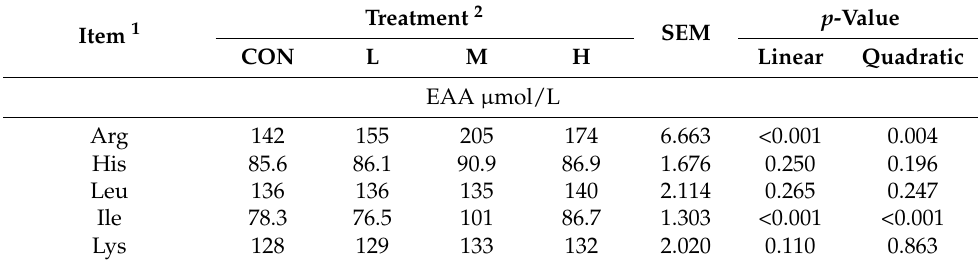
Table 5. Effect of supplementation with N-carbamylglutamate (NCG) on plasma amino acids in fattening Holstein